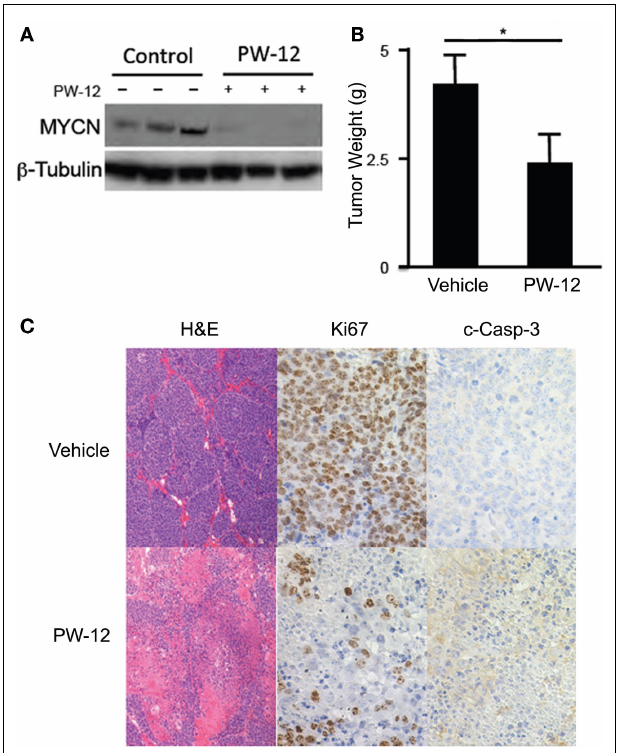
FIGURE 2 | PW-12 is efficacious in a GEM model of MYCN-amplified neuroblastoma . Tumor-bearing TH-MYCN mice were treated for 14days with either 25mg/kg of PW-12 ( n = 3) or vehicle alone ( n = 3). (A) Western blot for MYCN protein from treated tumors confirm that PW-12 is effective at downregulating MYCN protein production. (B) Tumor size was significantly reduced in treated animals (* represents p < 0.05). (C) Histology for Ki67 and c-Caspase 3 shows increase in apoptosis and decrease in proliferation in treated tumors.